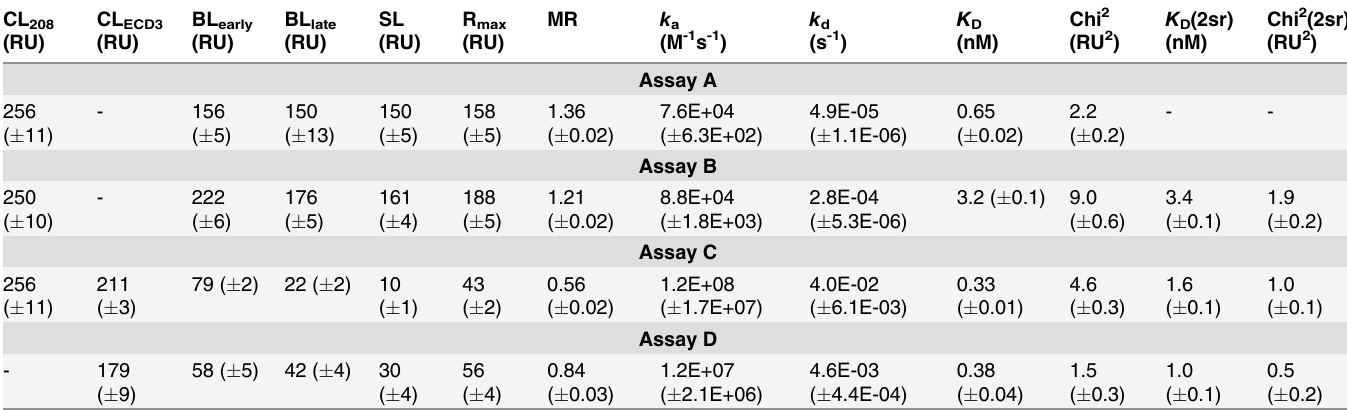
Table 1. Kinetic interaction parameters calculated by Biacore.